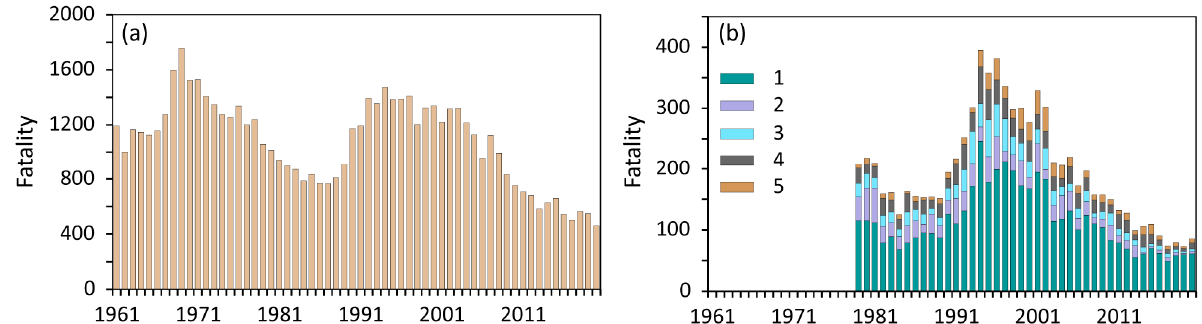
Figure 12. Annual numbers of all vehicle accident fatalities in the 1961–2020 period ( a ) and those related to inclement weather in the 1979–2020 period ( b ) in the Czech Republic according to police data [95,96]: 1—rain, 2—snow, 3—glaze ice, 4—fog, 5—other inclement weather.